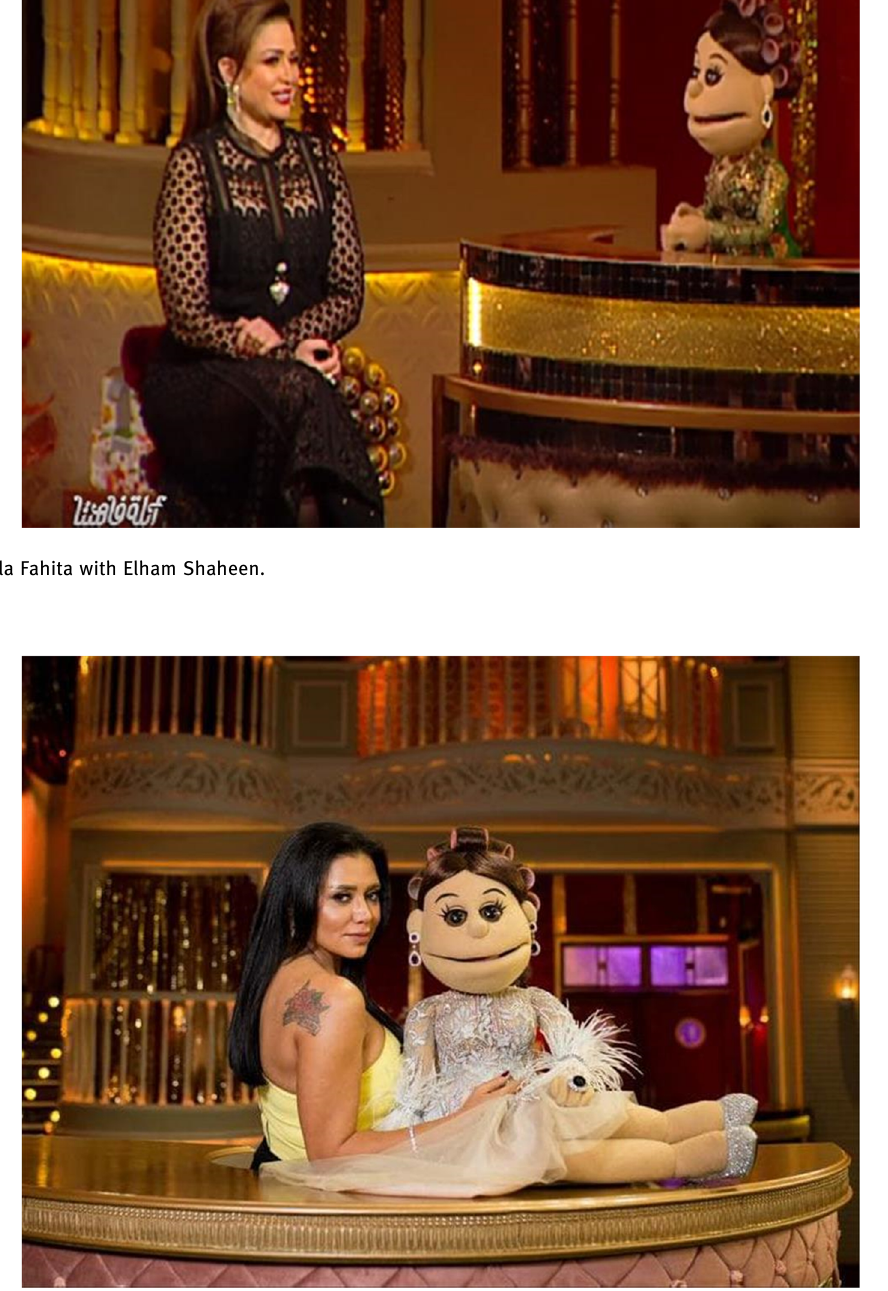
Figure 5: Abla Fahita with Rania